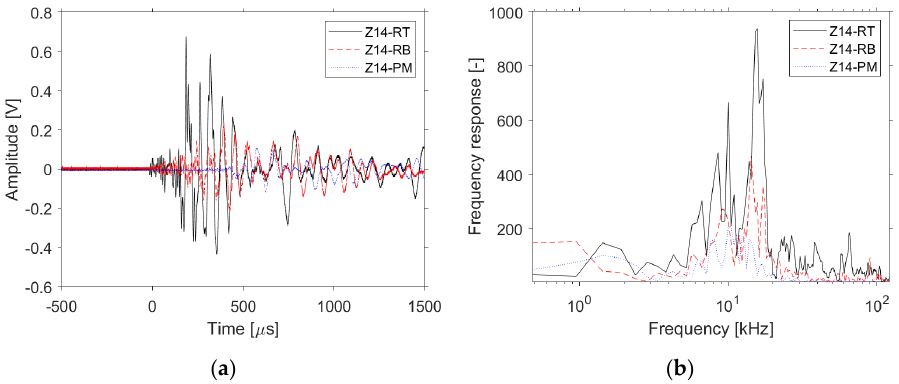
Figure 3. Acoustic emission (AE) signals acquired at three di ff erent locations: ( a ) time-domain signals and ( b ) frequency responses. Note that RT, RB, and PM indicate that a source was generated at the raft top, raft bottom, and pile middle. The AE sources were produced at Zone